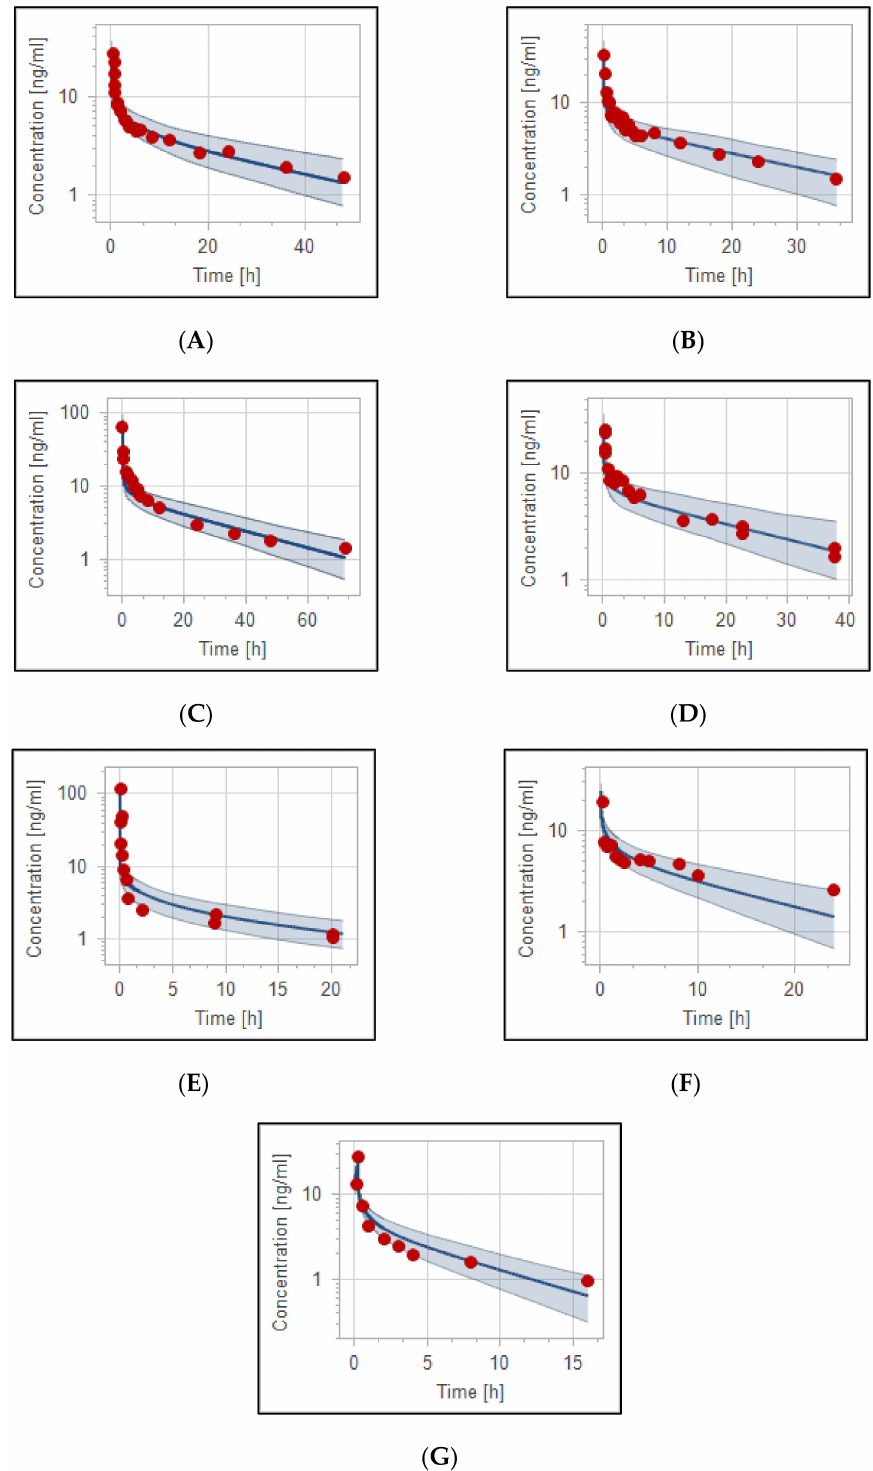
Figure 2. Plasma concentration–time profiles of haloperidol in adult healthy and psychotic otherwise healthy populations after intravenous administration. ( A ) 0.125 mg/kg [40], ( B ) 0.125 mg/kg [41], ( C ) 0.125 mg/kg IV [42], ( D ) 10 mg IV [43], ( E ) 5 mg IV [44], ( F ) 3.5 mg IV [46], ( G ) 2.5 mg IV [47]. Observed data are depicted as red circles and means of simulated data are depicted as solid blue lines with the 5th–95th predictive ranges as blue shaded